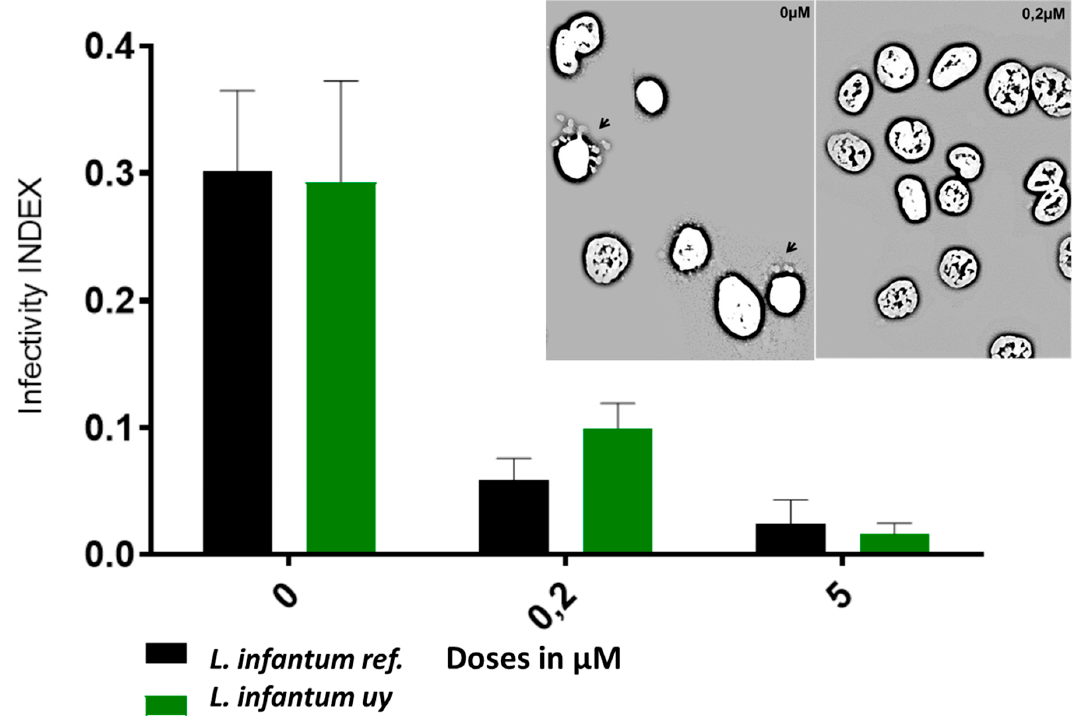
Figure 3. E ff ect of compound 8 at 200 nM and 5 µ M over human macrophages infected with L. infantum. The infectivity index is the ratio between the number of amastigotes per cell before and after treatment. A fluorescence microscopy image with DAPI (2-(4-amidinophenyl)-1H -indole-6-carboxamidine) staining of human macrophages infected with L. infantum is shown (0 µ M: Control and at the right side, cells treated with 0.2 µ M of compound 8 ).Amastigotes are shown with black arrows in the Control condition around the nucleus.